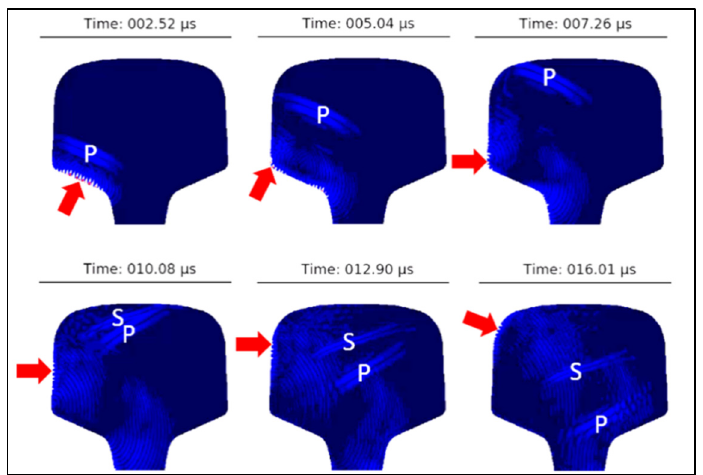
Figure 7. Simulated ultrasonic wave propagation in an undamaged rail head after introducing a wave corresponding to excitation with a comb transducer. The magnitude of the velocity field is shown for subsequent snapshots in time. The red arrow marks the position of the Rayleigh wave, “P” marks the pressure wave and “S” stands for the shear wave.